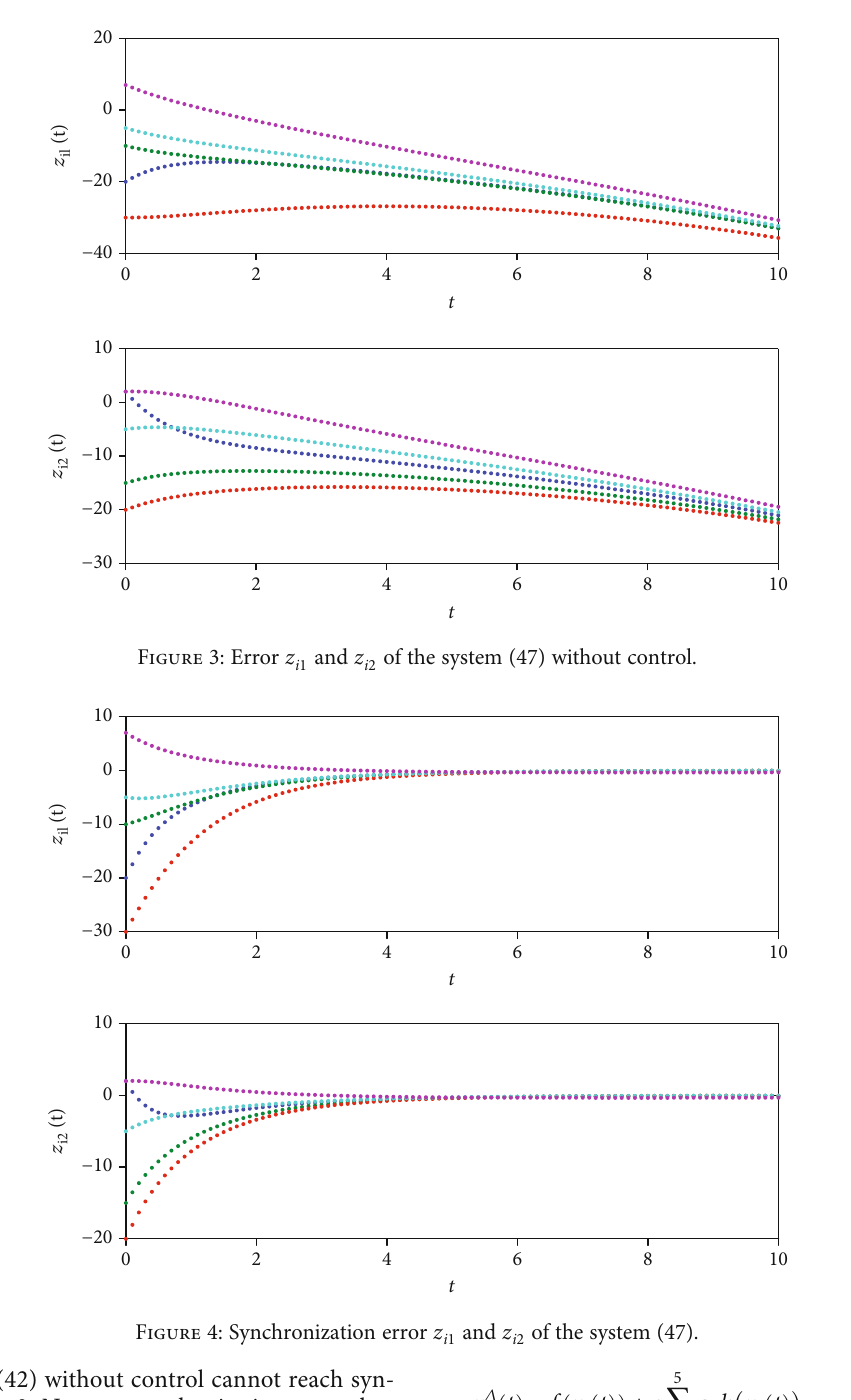
and z of the system i 1 i 2